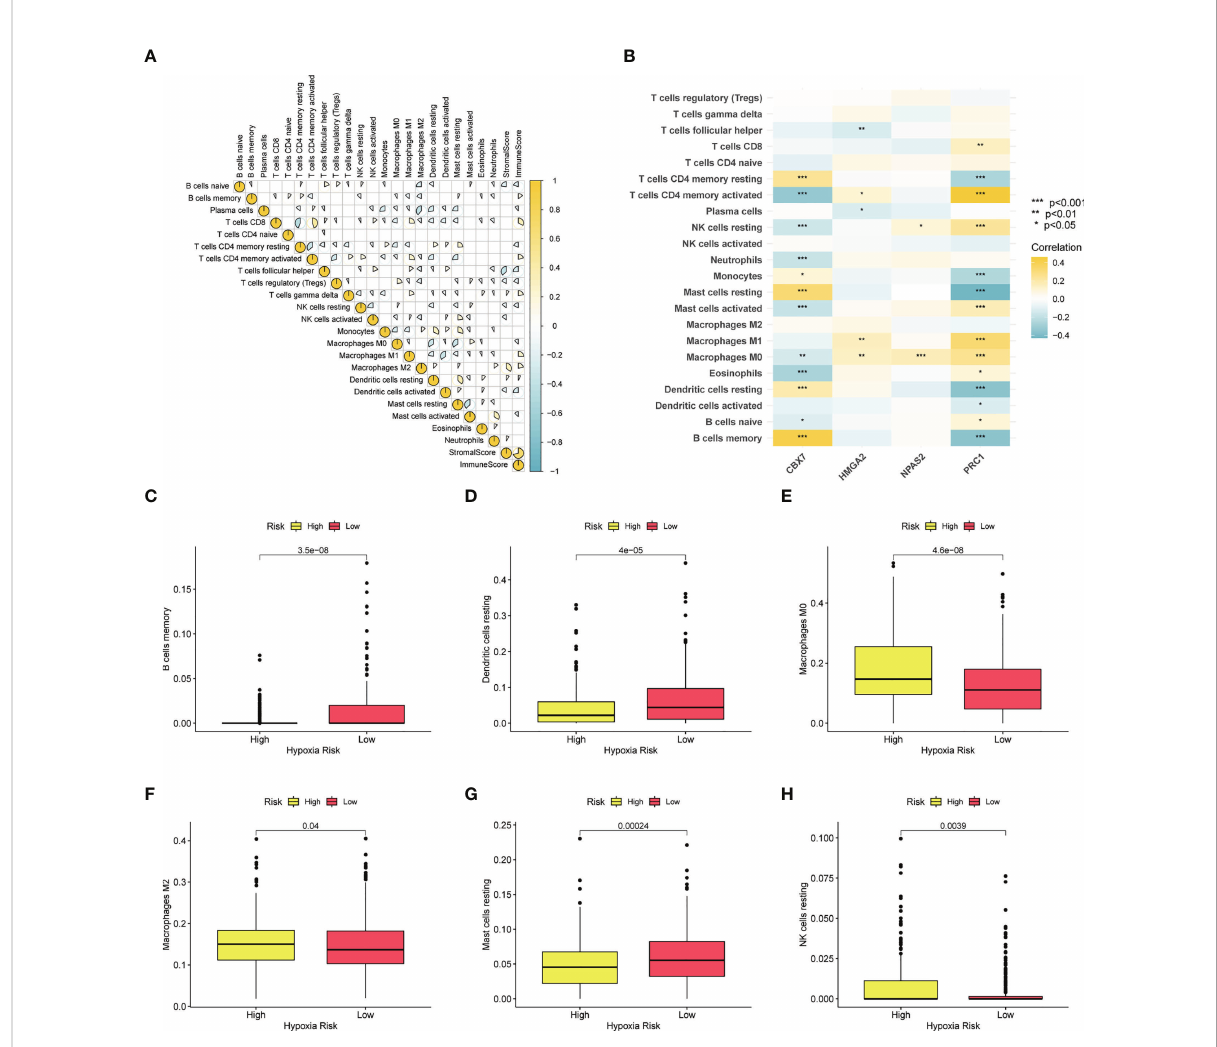
FIGURE 8 Immune in fi ltration analysis. (A) Correlation analysis of 22 immunocyte types. (B) Heatmap showing the relationship between four model CRs and immune cells. (C – H) The in fi ltration level differences of memory B cells, dendritic cells, macrophage M0, macrophage M2, mast cells and NK cells among two groups (*p< 0.05; **p< 0.01; ***p<